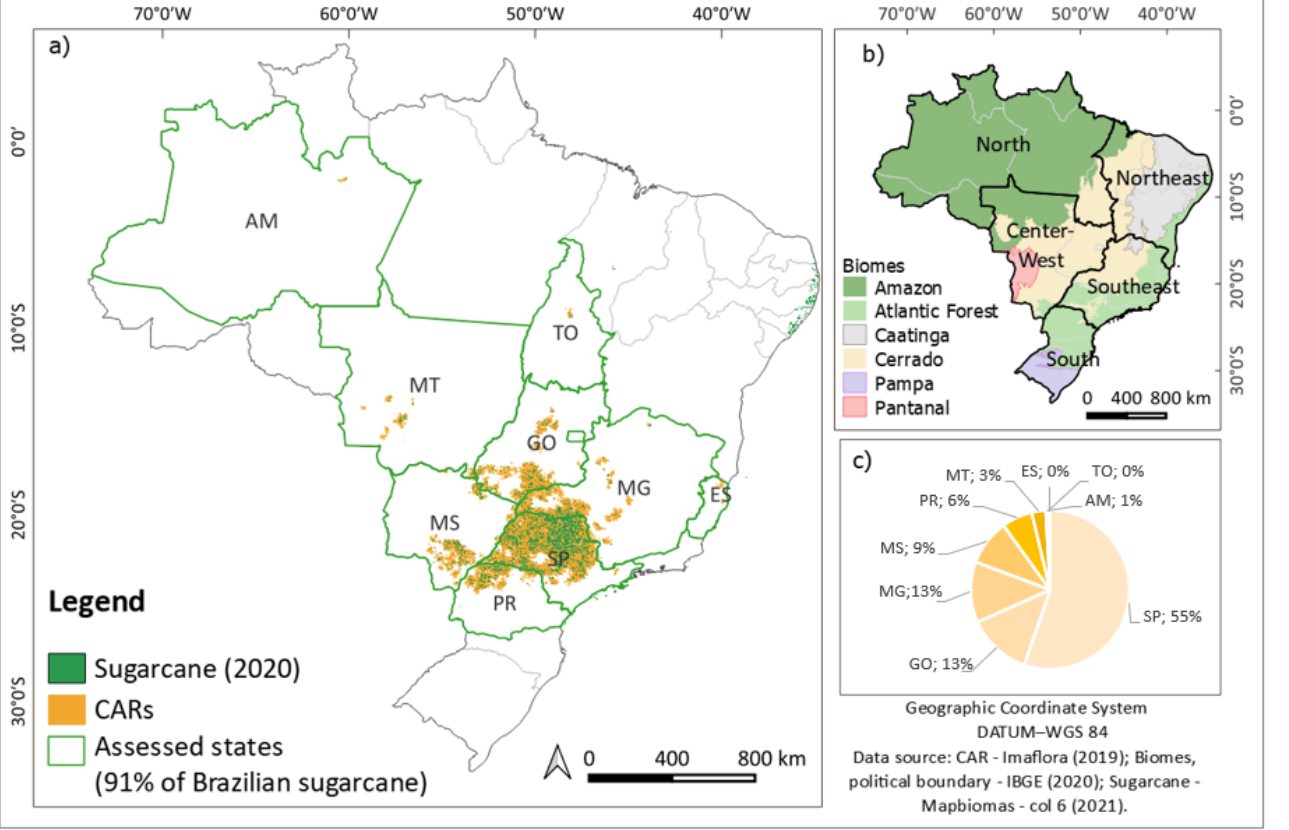
Figure 2. ( a ) Location of evaluated rural properties (CARs) and sugarcane area; ( b ) Brazilian regions and biomes, and ( c ) Distribution of the CARs by state in terms of area. Addressed states: São Paulo (SP), Minas Gerais (MG), Paraná (PR), Espírito Santo (ES), Mato Grosso (MT), Mato Grosso do Sul (MS), Goiás (GO), Amazonas (AM) and Tocantins (TO).